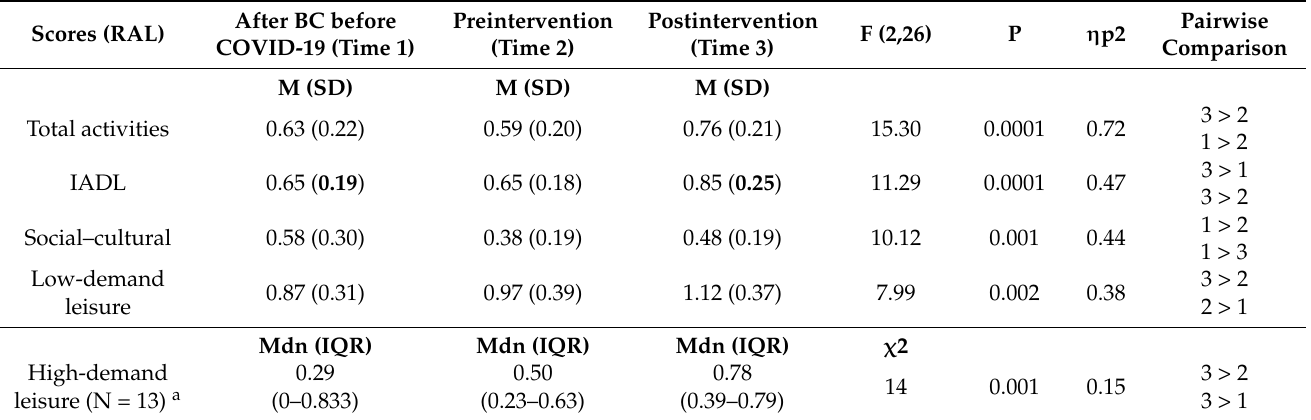
Table 3. Comparisons of participation in daily activities (Retained activity levels, by ACS) between three points of time (N =